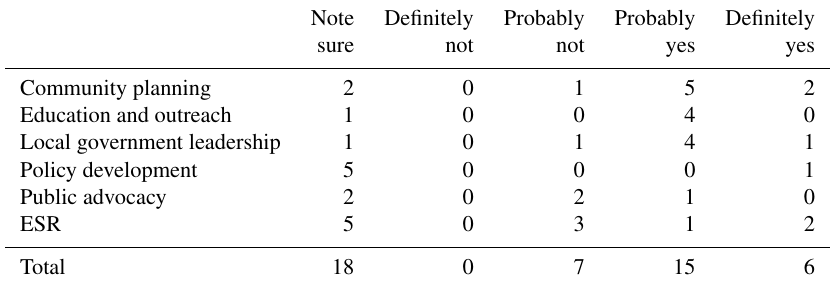
Table 4. Perceptions of community desire to implement climate adaptation planning in flood risk mitigation.